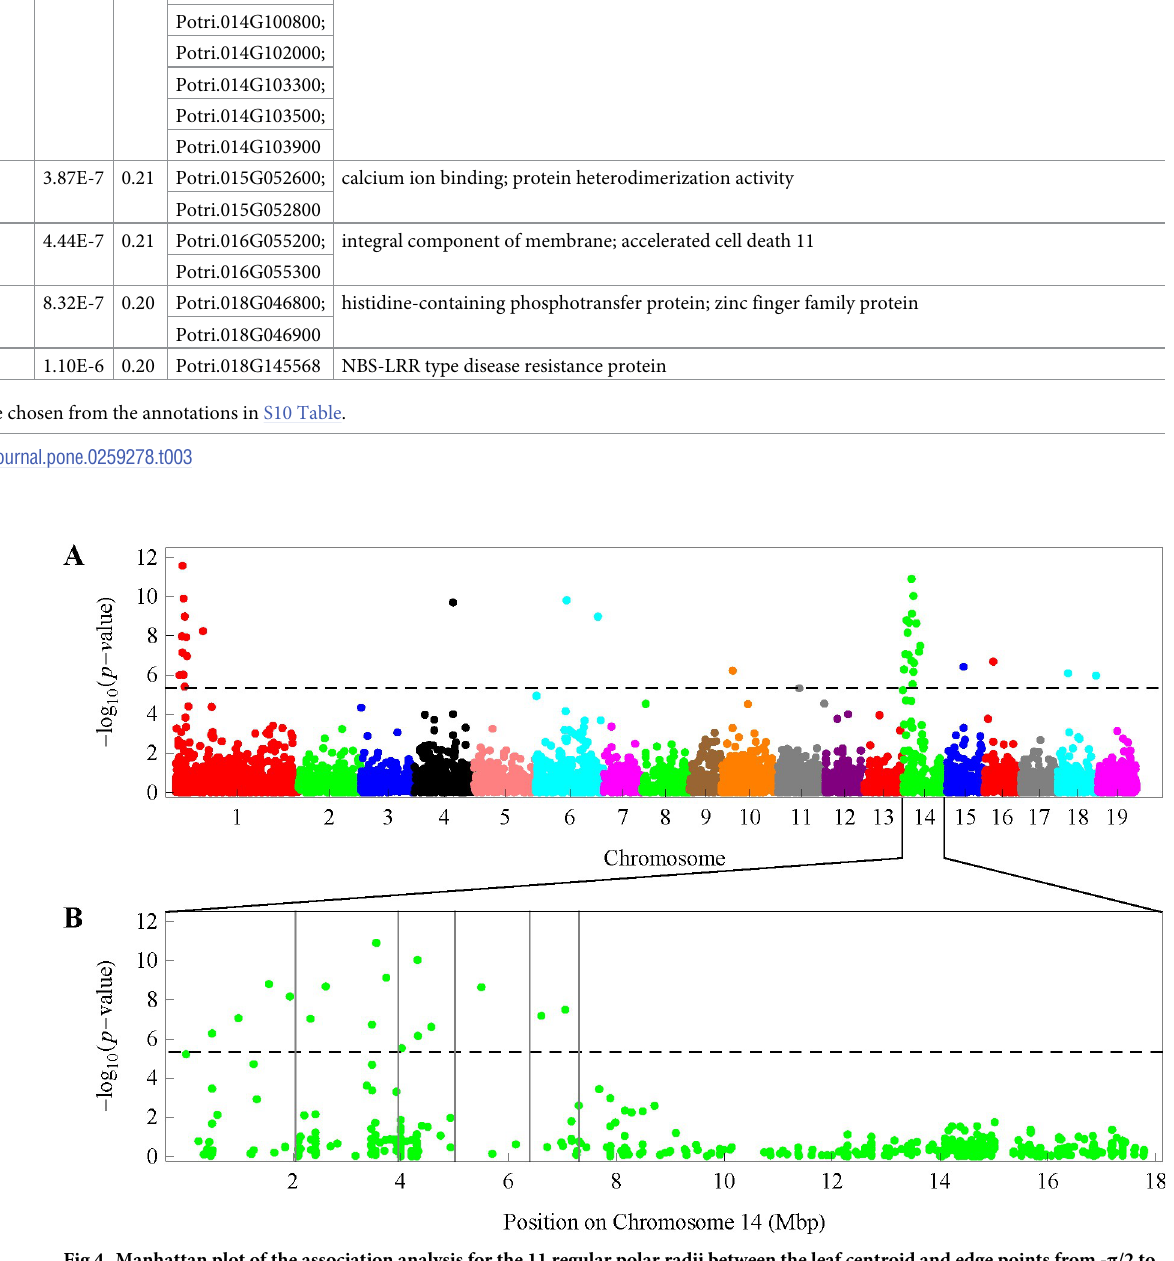
Fig 4. Manhattan plot of the association analysis for the 11 regular polar radii between the leaf centroid and edge points from - π /2 to π /2. (A) The plot shows the 19 chromosomes of the reference genome of P . trichocarpa . The horizontal dashed line indicates the genome- wide significance threshold of 5.33, which is a base 10 logarithm of the p- value based on the Bonferroni correction at the 0.05 significance level. (B) The significant SNPs on chromosome 14 were divided into five regions roughly according to the position where the negative logarithm of the p- value changes from decreasing to increasing.